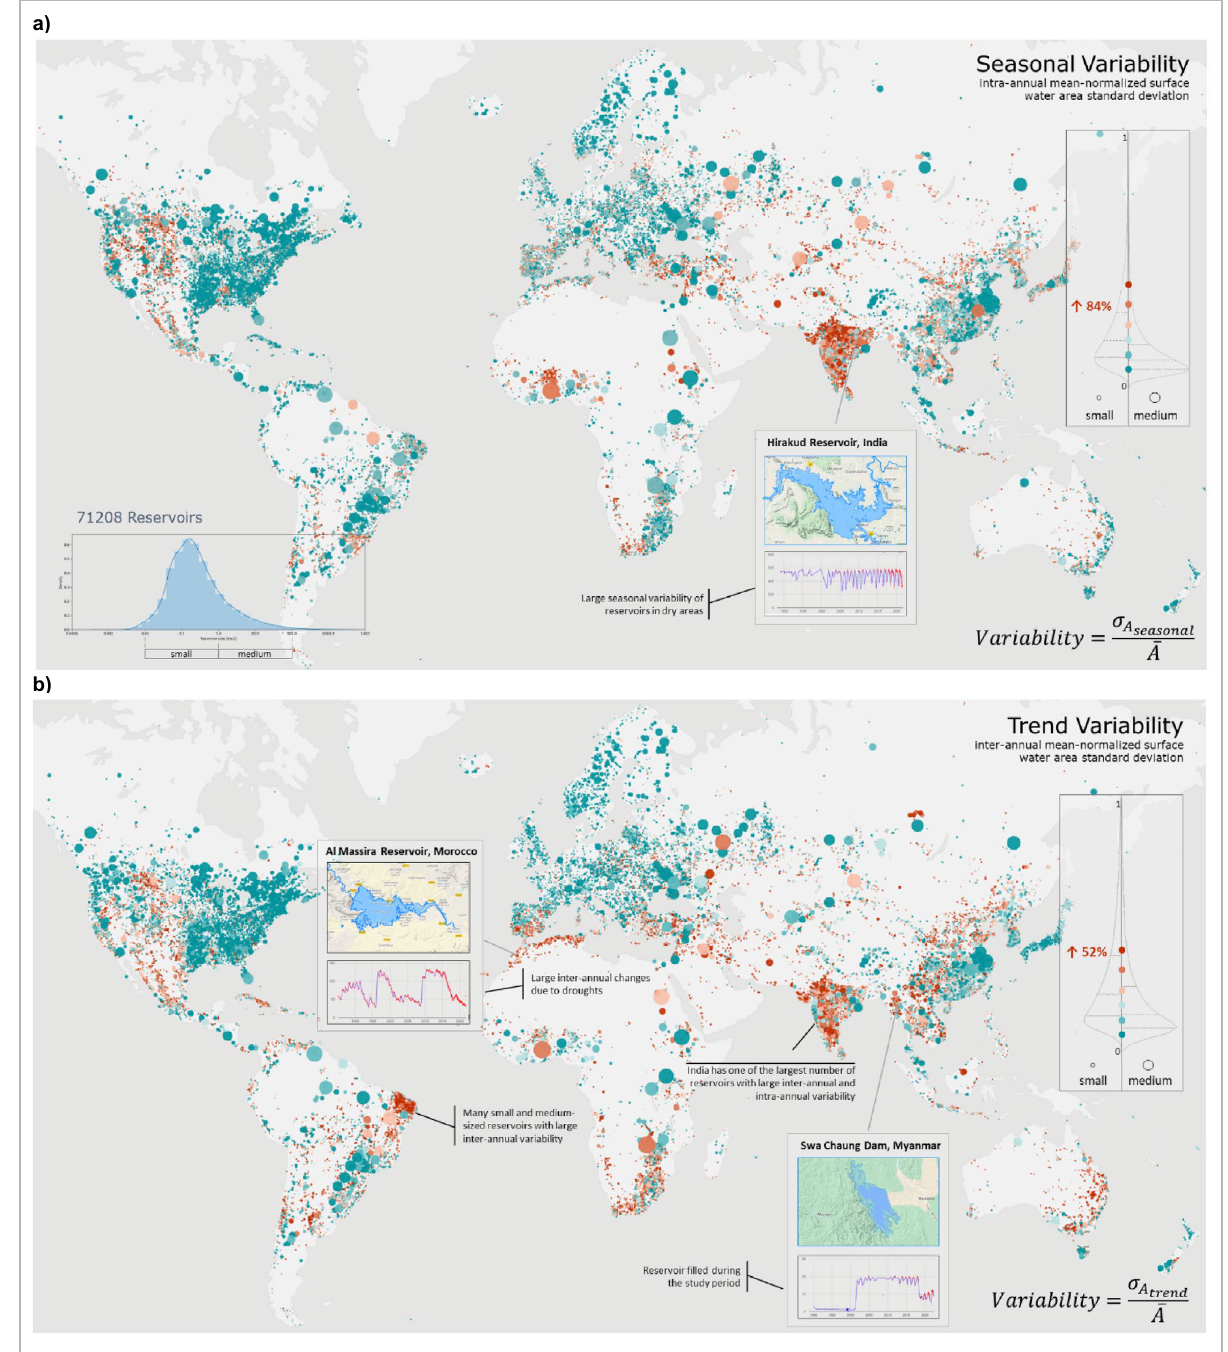
Figure 1. Overview of the reservoirs included in the database and their surface water area dynamics. The mean-normalized intra-annual (seasonal) ( a ) and inter-annual (trend) ( b ) variability of the surface water area of reservoirs, computed as a standard deviation of trend/seasonal components of surface water area time series divided by its mean area. Seasonal/Trend decomposition of surface water area time series is performed using statsmodels Python library 32 . The map is generated using Unfolded Studio 33 . Map: https:// studio. unfol ded.